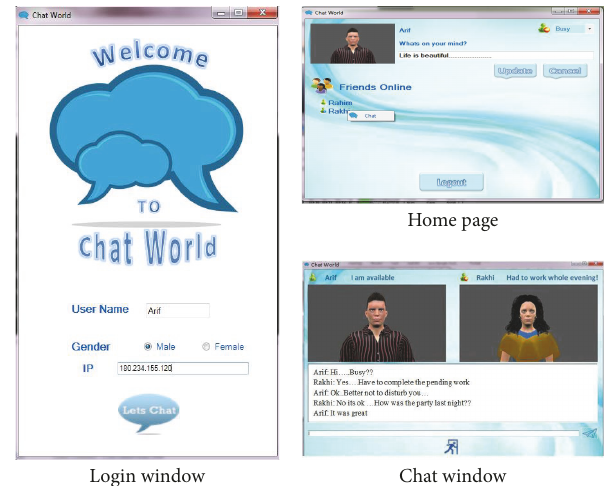
Figure 5: GUI of our proposed